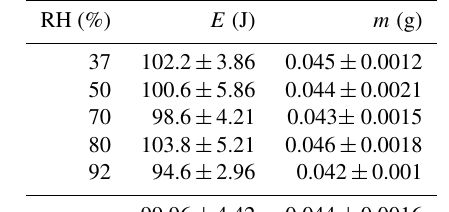
Table 2. Average and standard deviation mass ( m ) and energy loss ( E ) per droplet from the hotplate measured using the DEID for nu- merous relative humidity values (RH) for 0.04g water droplets.